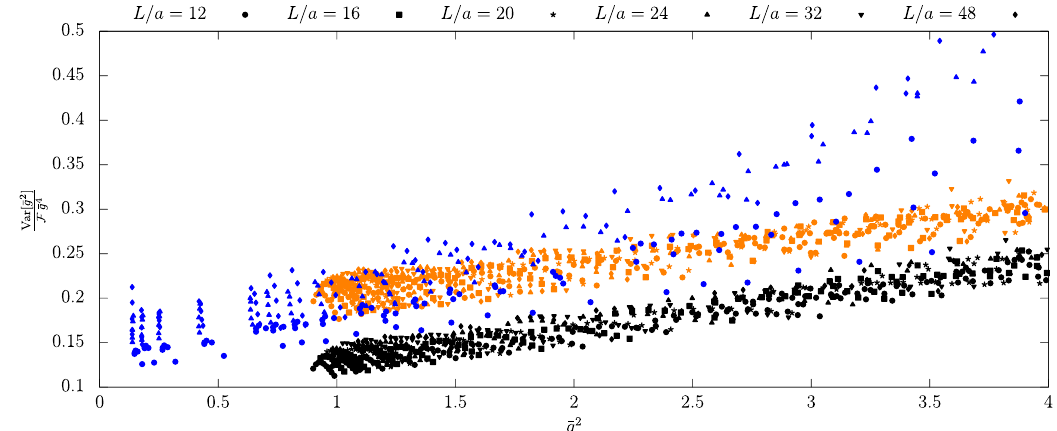
Fig. 8 Results for the quantity of Eq. (3.4) for three different datasets and six different lattice spacings. Orange symbols are for the “mag- netic” definition of the GF coupling; black symbols are for the average